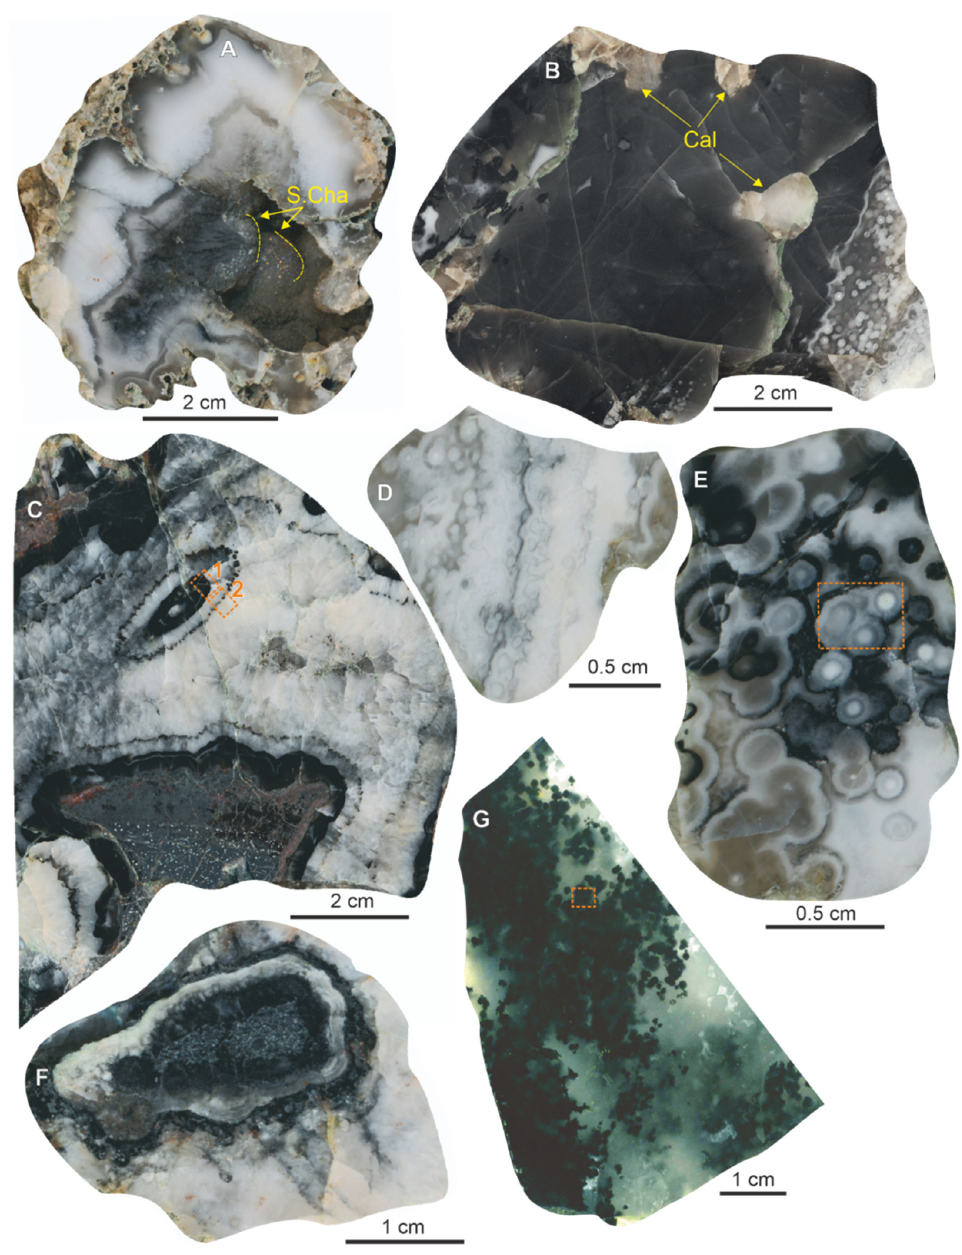
Figure 3. Photographs of Onega black agates in the Paleoproterozoic volcanics within the Onega Basin LSH (ZF). ( A ) Concentrically zoned agate with central cavity covered by sinter chalcedony (Glubokii Navolok), ( B ) uniform opaque agate with quartzine spherulites zone and large calcite inclusions (Suisari Island), ( C ) concentrically zoning agate with black ellipsoid (Suisari Island), ( D ) enlarged fragments of spherulitic zone from ( B ), ( E ) black and white spherulite agate (Glubokii Navolok), ( F ) concentrically zoned agate (Glubokii Navolok), ( G ) moss agate composed by colourless chalcedony with black-rounded segregations of carbonaceous matter (Suisari Island). S. Cha—sinter chalcedony, Cal—calcite. The areas of optical microscopy analysis are marked with orange squares, explanations in Figure 4.